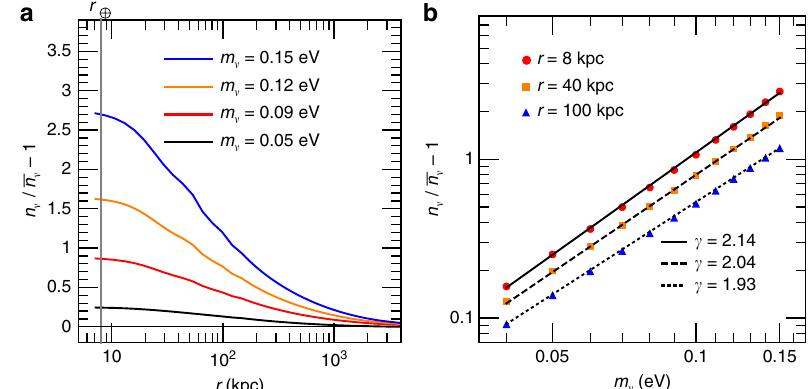
Fig. 2 Clustering of fully degenerate relic neutrinos in the MW. The descriptions of a , b are the same as those in Fig.